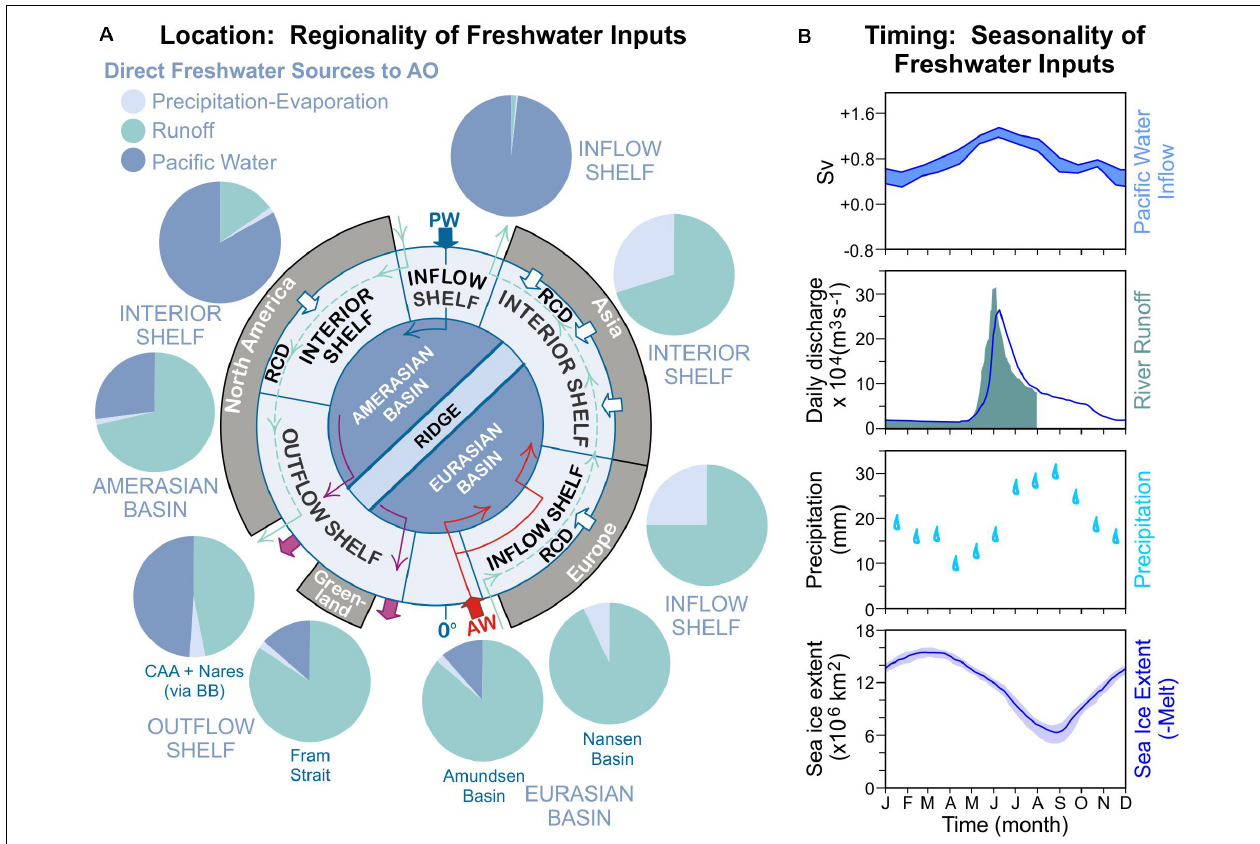
FIGURE 4 | Regionality and seasonality of freshwater sources to the Arctic Ocean. (A) Regionality of freshwater sources: Conceptual representation of the regionality of freshwater sources (Annual runoff, RO, primarily from rivers; Precipitation-Evaporation, P-E; and Pacific Water, PW) to the Arctic Ocean (AO) showing the fractional contribution of each local freshwater source, with literature sources in Table 3 . Note: Pacific Inflow shelves average freshwater inputs were estimated based on mean annual RO and P-E as a component of the 1 Sv of PW entering through Bering Strait annually. Pacific Interior shelf freshwater components were estimated with RO and P-E inputs scaled to an average meteoric water content of 20% for Polar Mixed Layer. Amerasian Basin freshwater components were determined by averaging estimates for the Makarov Basin and the Canada Basin. Depending on the location of the Pacific-Atlantic front, the amount of PW in the Eurasian Basin can be quite variable. Here we have separated the Nansen Basin and the Amundsen Basin to illustrate the presence-absence of PW. For the Atlantic Outflow shelves, we separate the CAA and Nares Strait outflow via Baffin Bay and Fram Strait. In all regions, Sea Ice Melt is considered a mixture of freshwater sources and would have the same fractional composition as surface waters. It should also be noted that the freshwater composition of each region is, at best, a qualitative description based on the time interval and regional coverage of the referenced study, and, in most cases, the components were determined using different geochemical tracers, data sets from different seasons, and different methods. For further insight, please see the referenced studies. Central map as in Figure 1B . (B) Seasonality of freshwater sources: Conceptual representation of the seasonality of freshwater inputs to the AO, as in (a), with literature sources as in Table 3 . Pacific Water inflow climatology from 1990 to 2004 (purple shaded area; top panel). River runoff to the AO (second panel from the top), including average combined daily discharge for Eurasian rivers: Severnaya Dvina, Pechora, Ob’, Yenisey, Lena, and Kolyma for the period of January 1st to July 31st, 2015 (green shaded area); 1980–1989 average for January to July (dark blue line). Arctic precipitation climatology (third panel from the top) from 1957 to 1990. Arctic Sea Ice Extent (bottom panel) includes 1981–2010 median (dark blue line) and interdecile range (shaded